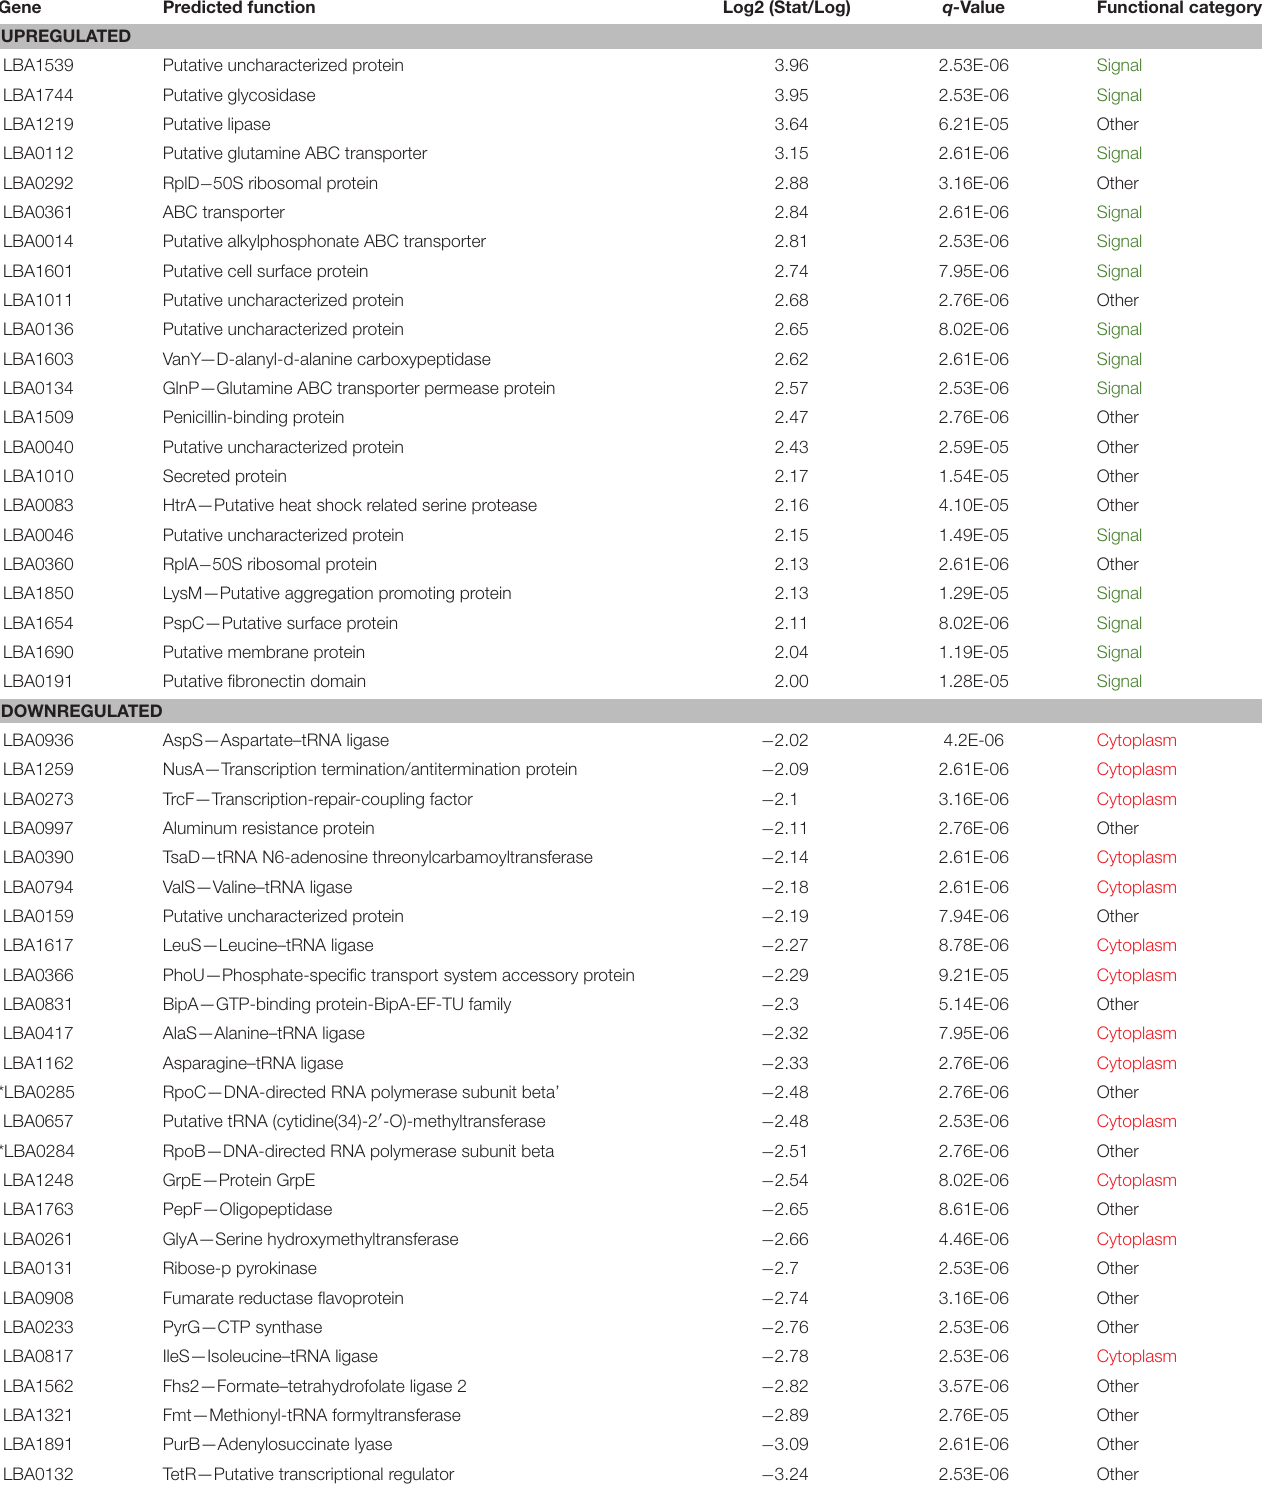
* Previously reported moonlighting function. Red and green coloring corresponds with volcano plot in Figure 4 .